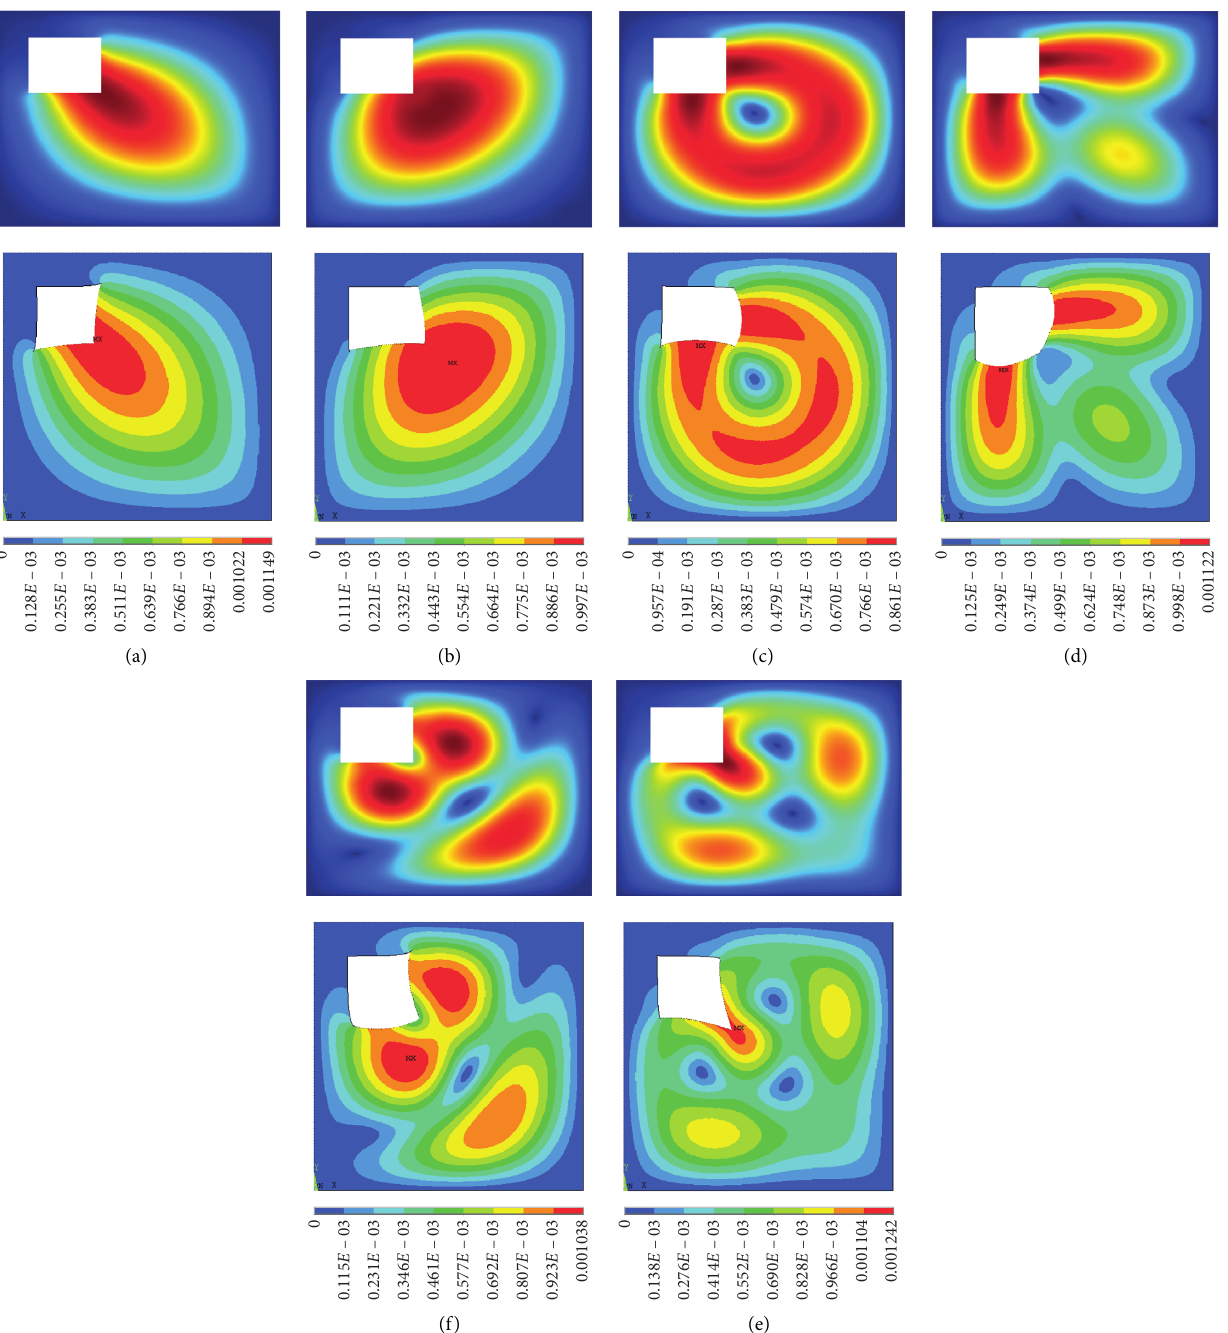
Figure 6: The first six mode shapes for the square plate with a cutout whose size is 10m × 10 m. (a) The first mode; (b) the second mode; (c) the third mode; (d) the fourth mode; (e) the fifth mode; (f) the sixth mode. Upper: the present results; lower: the ANSYS